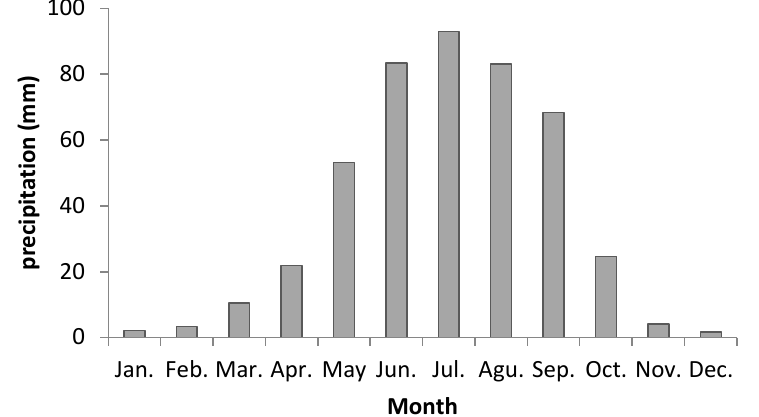
Figure 4. Average monthly precipitation during the period 1981–2010 in the spring wheat regions of the Tibetan plateau area of China.